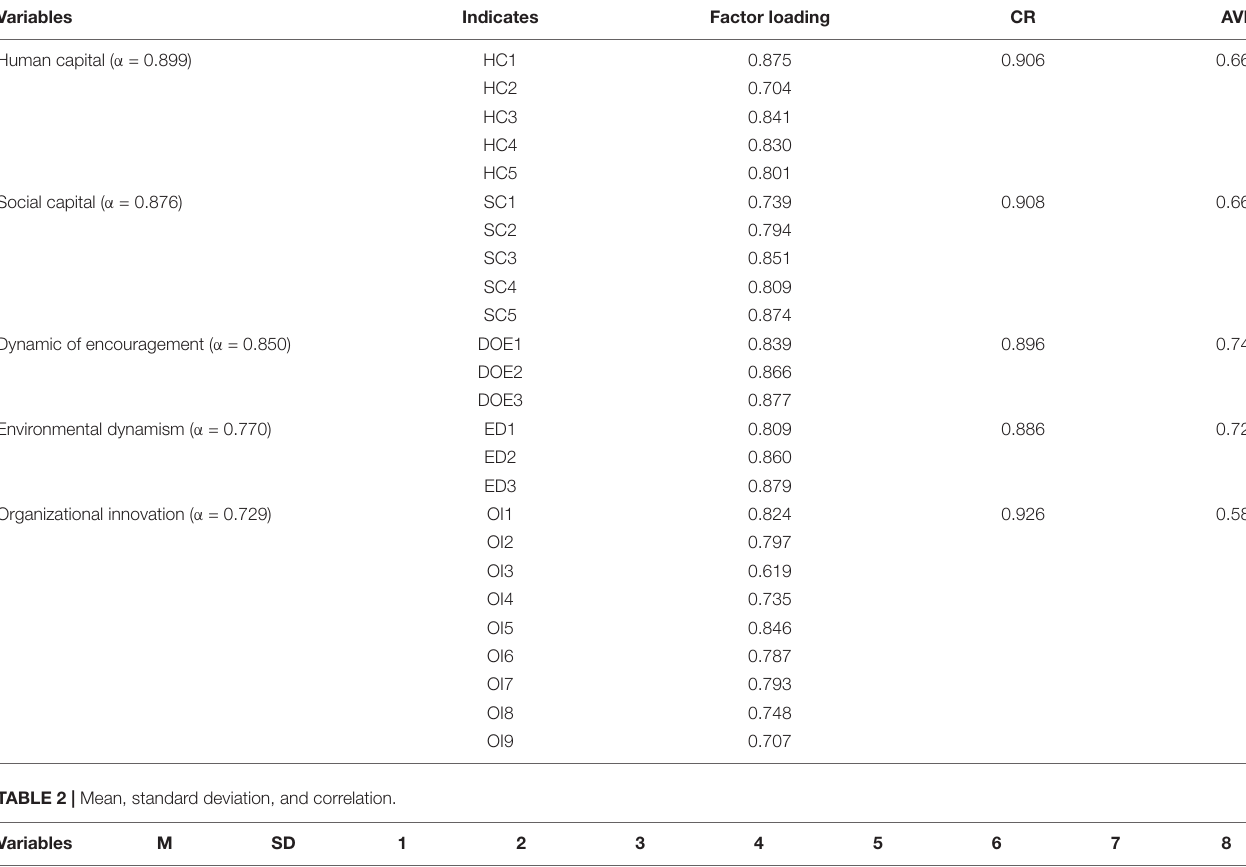
TABLE 1 | Confirmatory factor analysis and scale reliability. Variables Indicates Factor loading CR AVE